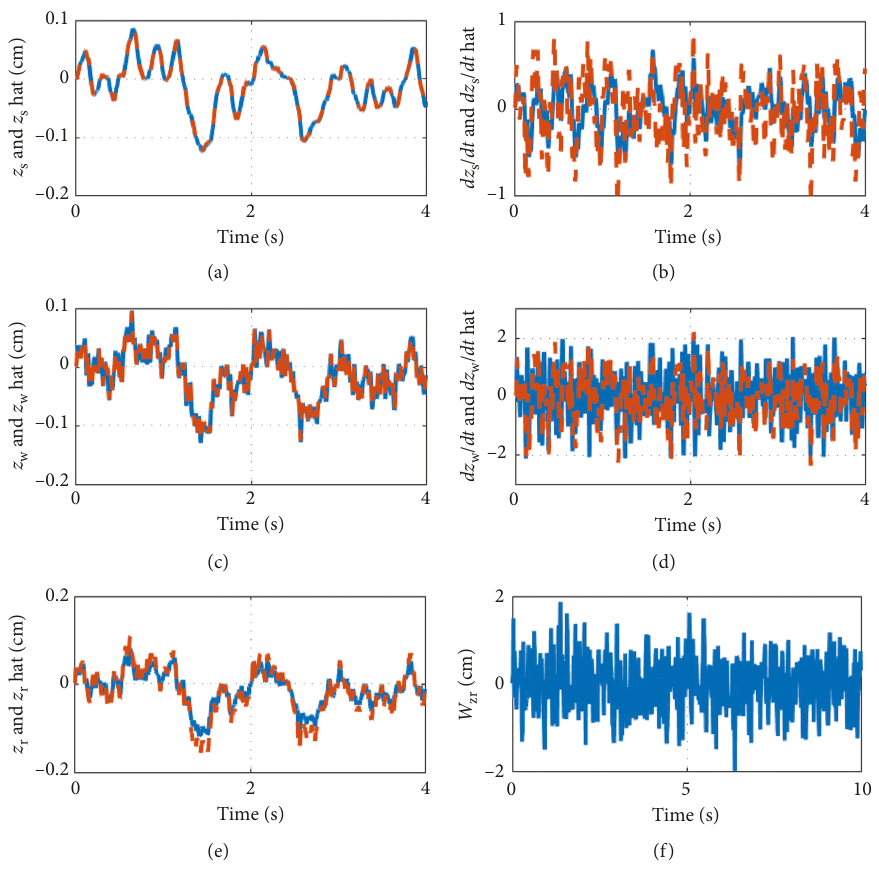
Figure 14: The real states (solid line) and estimated states using SPKF (dotted line) in the case of 40km/h. (a) z dt hat. (c) z w and z w hat. (d) dz w / dt and dz w / dt hat. (e) z r and z r hat. (f) w